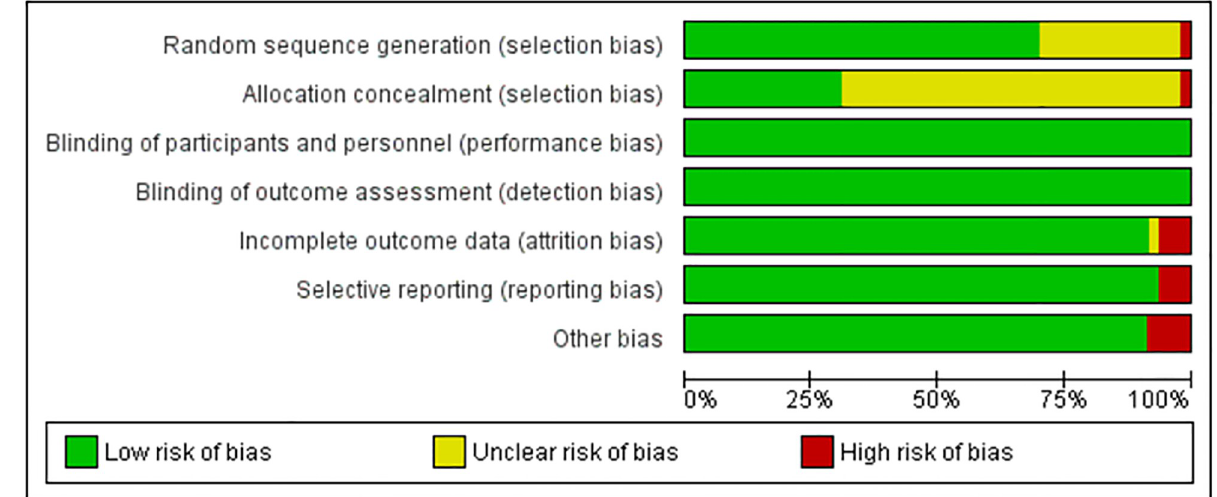
Fig 2. Risk of bias graph: Review authors’ judgments about each risk of bias item presented as percentages across all included studies.